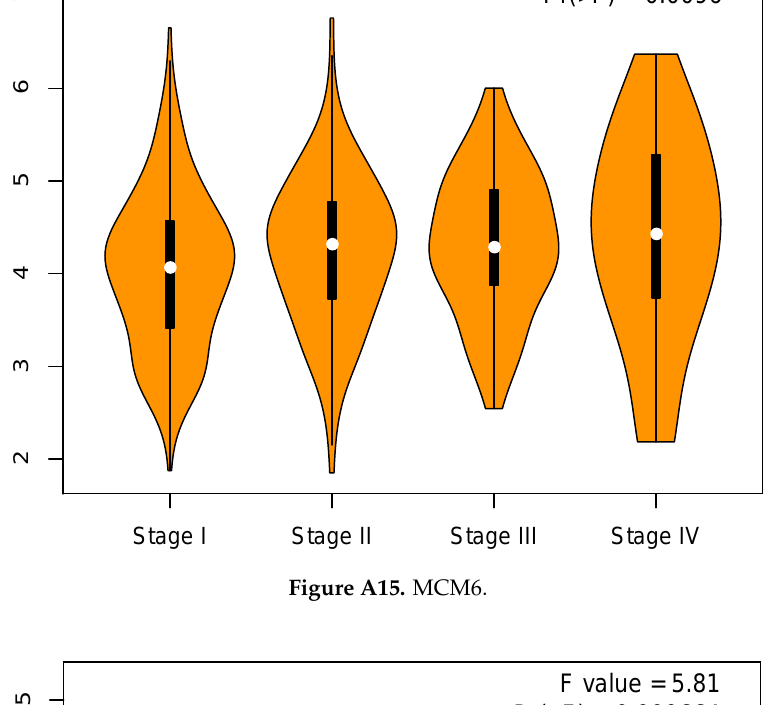
Figure A15. MCM6.